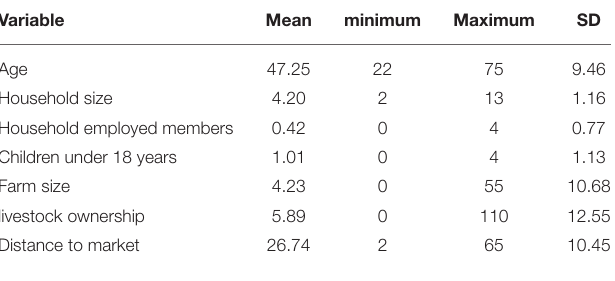
TABLE 3 | Descriptive statistics of continuous variables.